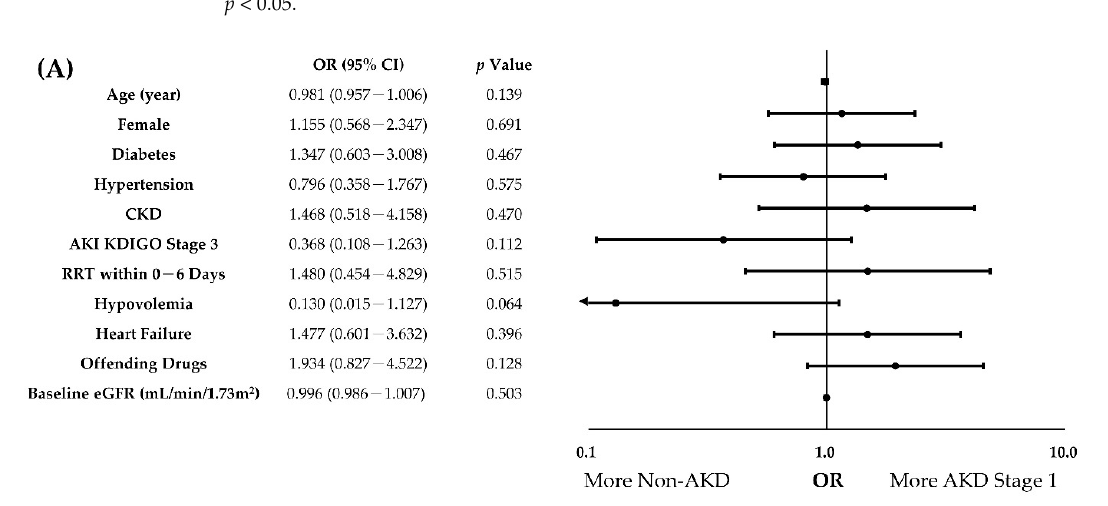
Figure 2. Forest plots of independent predictors of AKD severity in patients with AKI. ( A ). AKD Stage 1 vs. non-AKD; ( B ) . AKD Stage 2 vs. non-AKD; ( C ). AKD Stage 3 vs. non-AKD. Age, sex, diabetes, hypertension, and covariates with a p -value of < 0.10 in univariate analyses were adjusted for multinomial logistic regression analysis with the enter method. CI, confidence interval; CKD, chronic kidney disease; eGFR, estimated glomerular filtration rate; OR, odds ratio. *: p < 0.05.